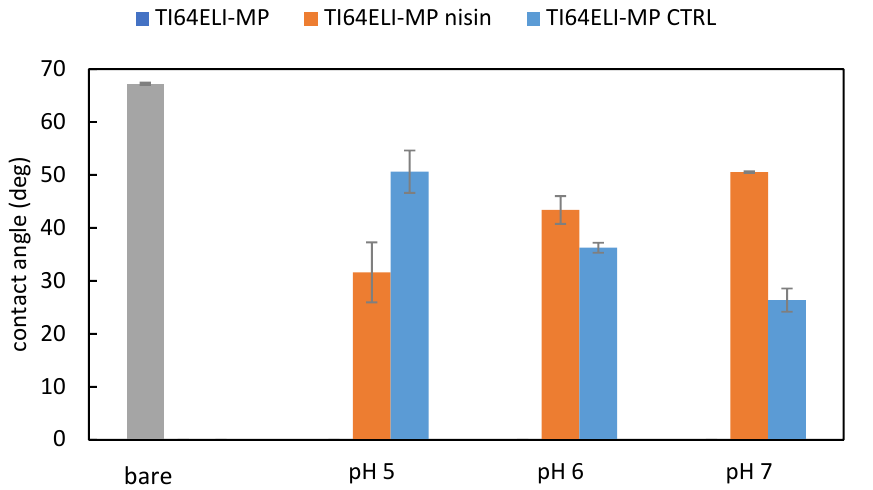
Figure 5. The contact angles measured on the bare MP sample (grey), samples functionalized with processes at different pH values (orange), and control samples soaked in solutions at different pH without nisin (blue).